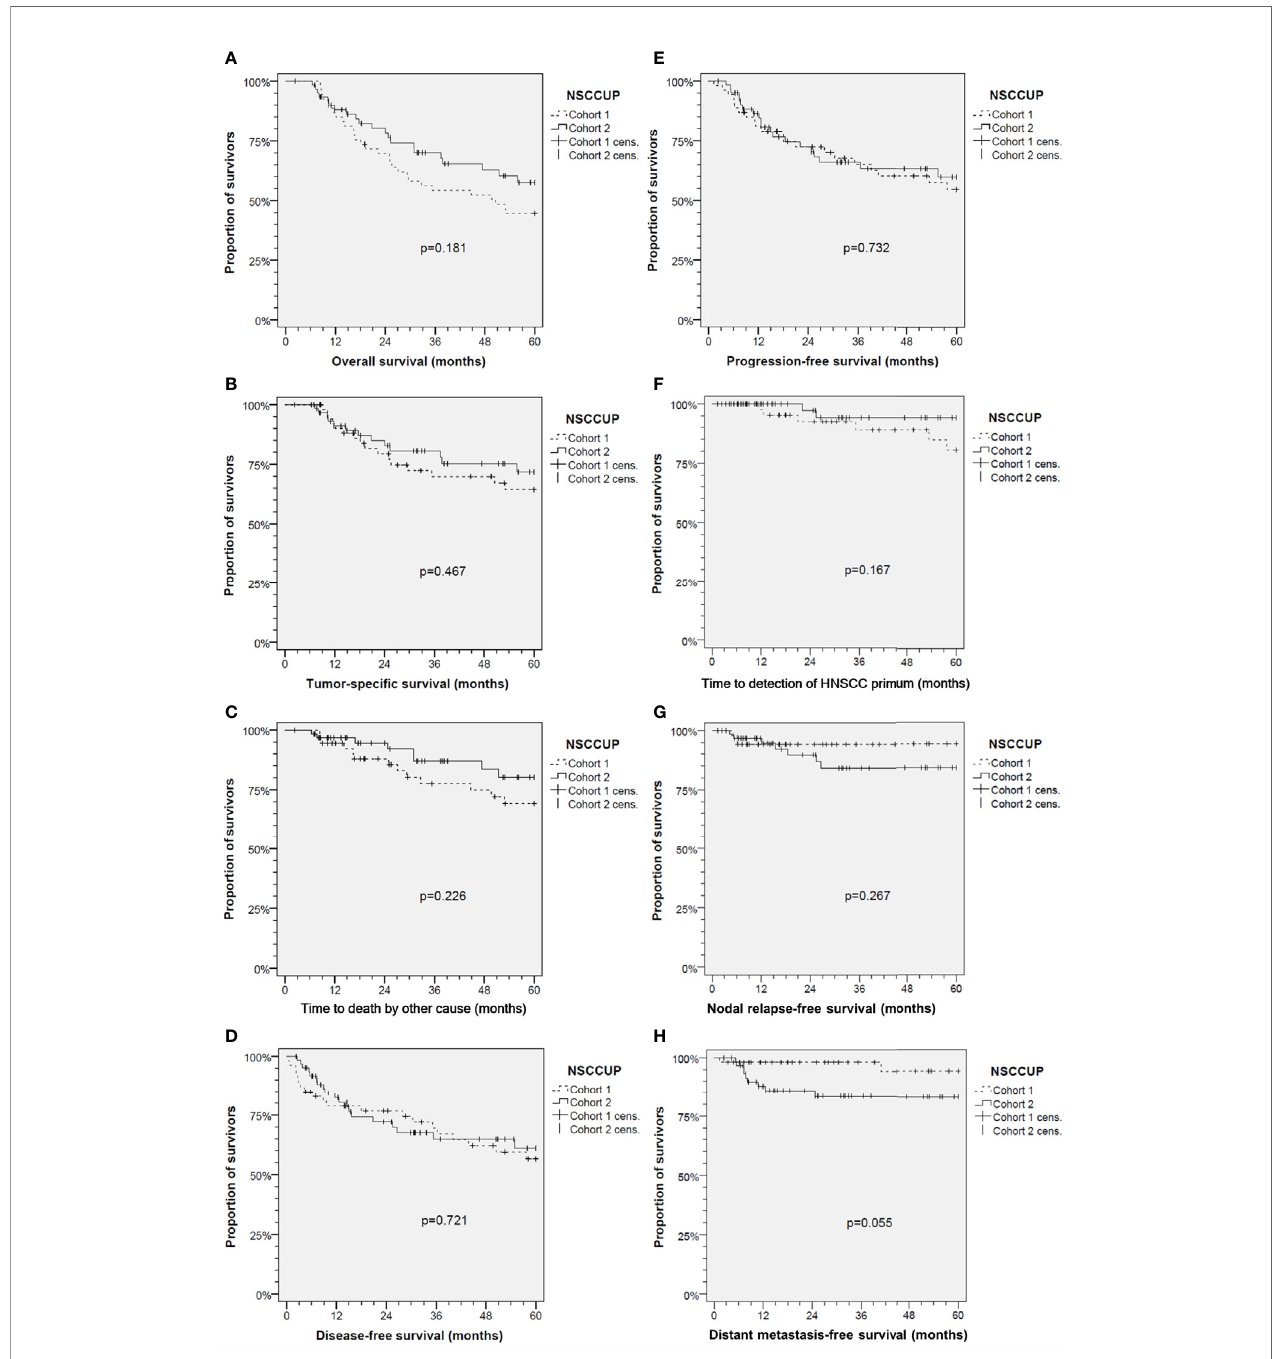
FIGURE 2 | Kaplan – Meier cumulative survival analyses of neck squamous cell carcinoma of unknown primary (NSCCUP) patients of cohorts 1 and 2 for (A) overall survival; (B) tumor-speci fi c survival; (C) survival according to non-cancer death/death from other cause; (D) disease-free survival; (E) progression-free survival; (F) Time to detection of head and neck squamous cell carcinoma primary; (G) Nodal relapse-free survival and (H) Distant metastasis-free survival. P values shown are from 2-sided log-rank